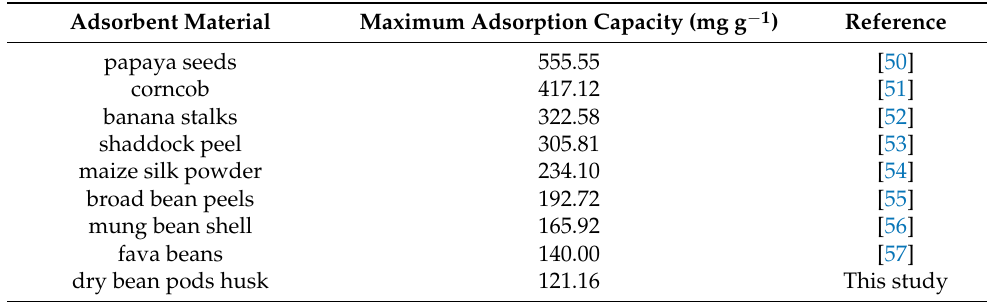
Table 5. Maximum adsorption capacities for a number of previously similar studied adsorbents.